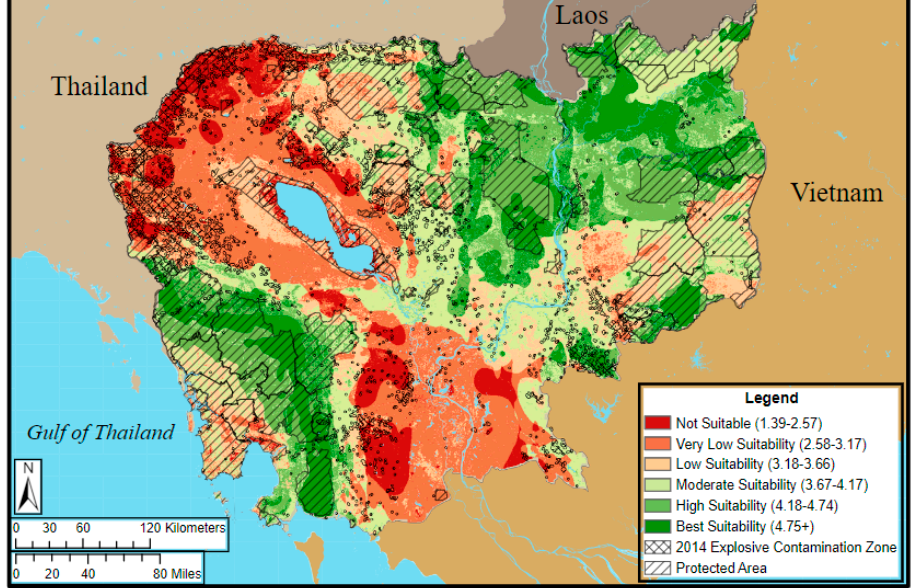
Figure 7. Cambodia water harvesting suitability.